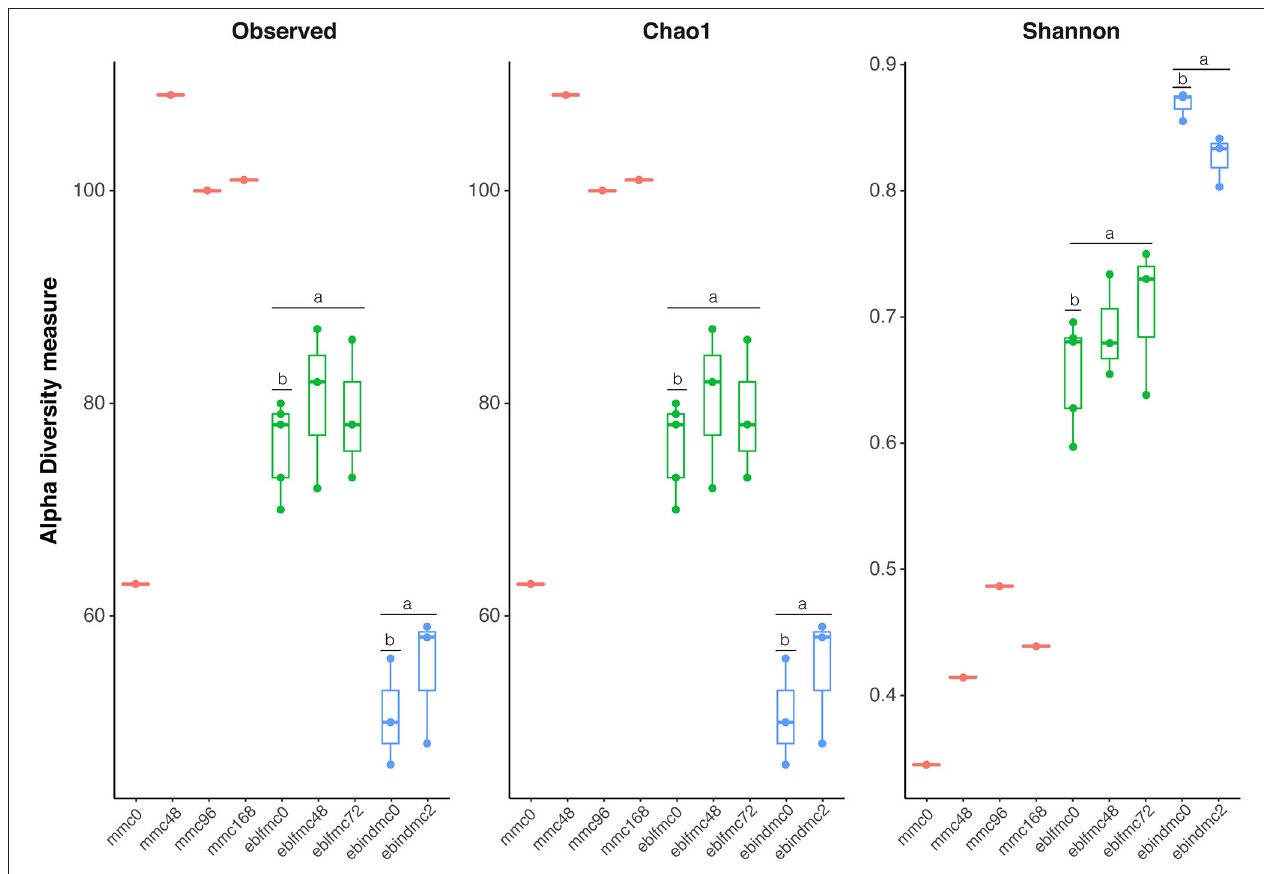
FIGURE 2 | Yeasts’ richness and diversity indices (18S rRNA gene) obtained from the massive sequencing analysis of the different types of bread doughs (MMC, sourdough; eblfmc, Elias–Boulanger long-fermentation raw dough; ebindmc, Elias–Boulanger industrial raw dough) at different times of fermentation. Statistical comparisons between eblfmc and ebindmc groups are indicated by superscript letters: same letters indicate statistically significant differences ( p <